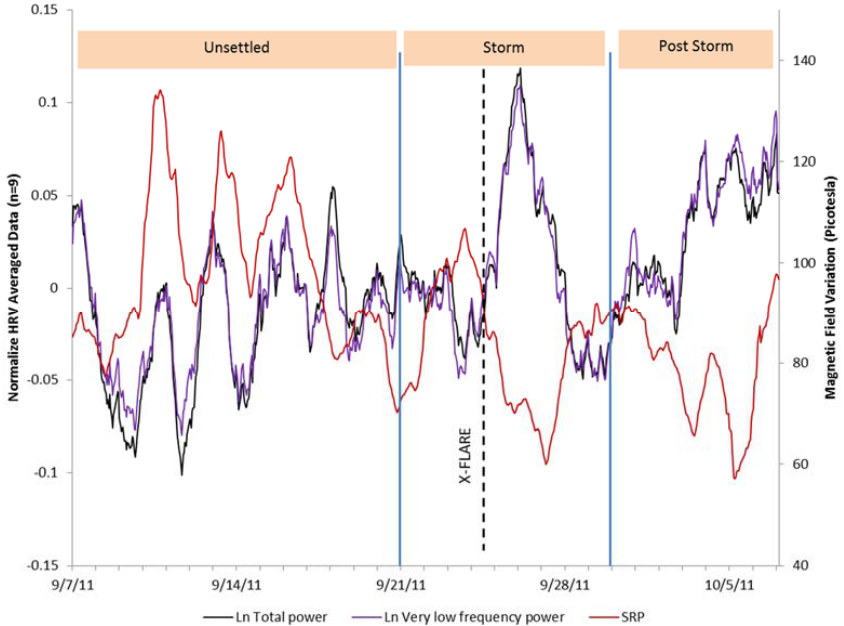
Figure 4. HRV total power and very low frequency power measures with the Schumann resonance power variations overlaid.